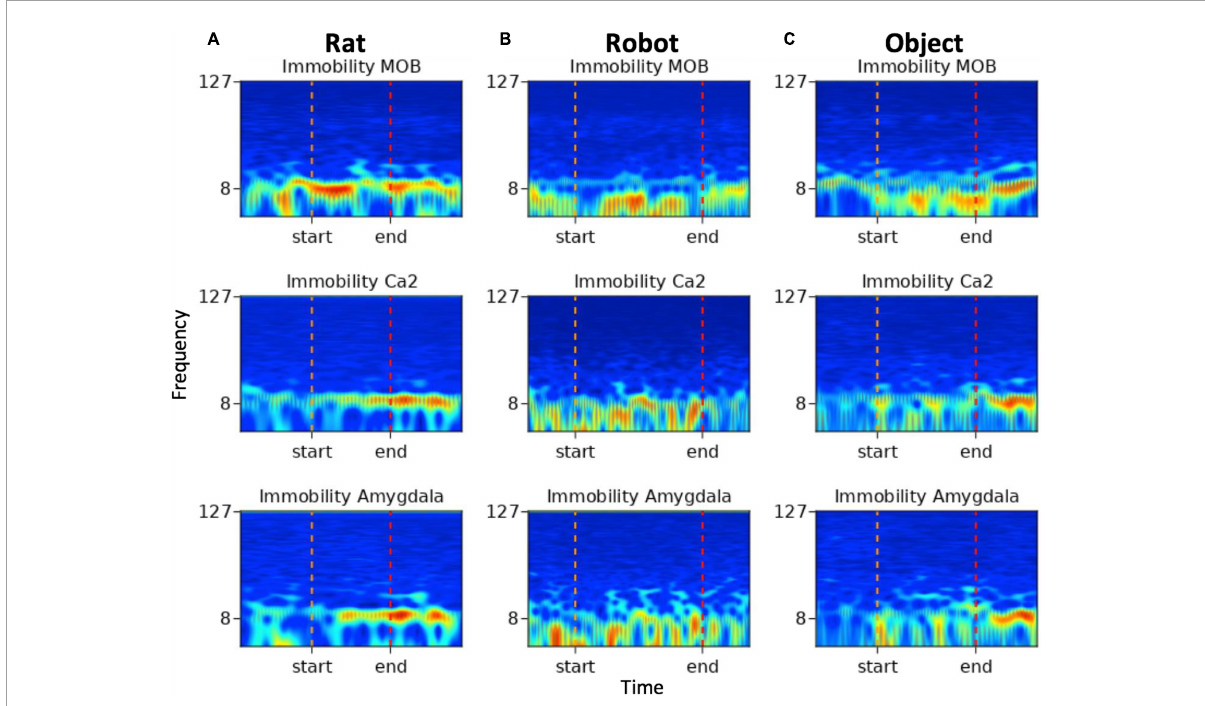
FIGURE7 Spectrograms of immobility events from (A) rat, (B) robot, and (C) object conditions. Frequency (Hz) is represented along the y -axis with markers for 8 and 127 Hz, time is represented along the x -axis, the color map represents high amplitude in red and low amplitude in blue. The start and end indicators denote the onset and offset of the variable duration behavioral events.